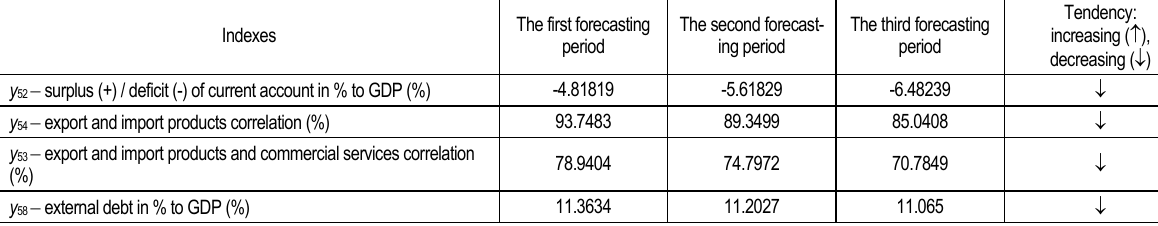
Table 4 (cont.). Forecasting meanings of indexes of socioeconomic state of Brazil Indexes